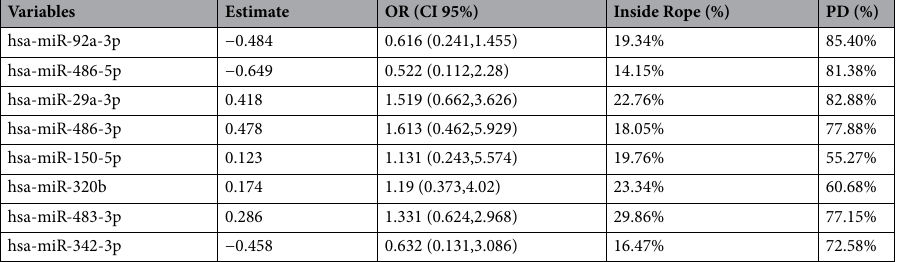
Table 3. Characteristics of the Bayesian model including 3 participants groups (control, preclinical-AD, MCI-AD). The Probability of Direction (PD) is an index of effect existence, ranging from 50 to 100%, representing the certainty with which an effect goes in a particular direction. PD > 80% was considered significative. For each variable the direction depends on the estimate (negatives estimate < 0, and positives estimates > 0). Region of Practical Equivalence (ROPE) defines the percentage of the area that is within the region of practical equivalence (equivalent to null effect). OR odds ratio, CI confidence interval.